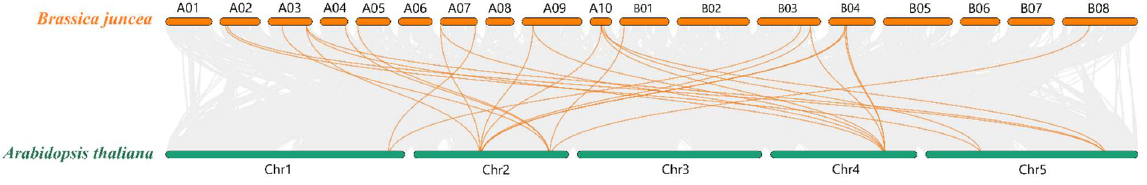
Figure 4. Collinearity analysis of CKX gene families in B. rapa , B. juncea , and B. nigra . The colored round rectangles represent the chromosomes of three cruciferous plants. The gray curves connect protein-coding genes in the synteny blocks, and the blue and green curves represent gene pairs that are collinear with UBC genes in B. juncea / B. rapa and B. juncea / B. nigra , respectively. 3.5. Analysis of Gene Structure and Conserved Motifs Analysis of CKX gene structure in B. juncea demonstrated that BjuCKX09 contained 9 introns and 10 exons, and the range of the number of exons of the remaining BjuCKX genes varied slightly, ranging from 3 to 5 (Figure 5). Among them, 16 BjuCKX genes con- tained 5 exons, 5 BjuCKX genes had 4 exons, and 1 BjuCKX gene ( BjuCKX17 ) only con- tained 3 exons and the length of exons was highly similar.